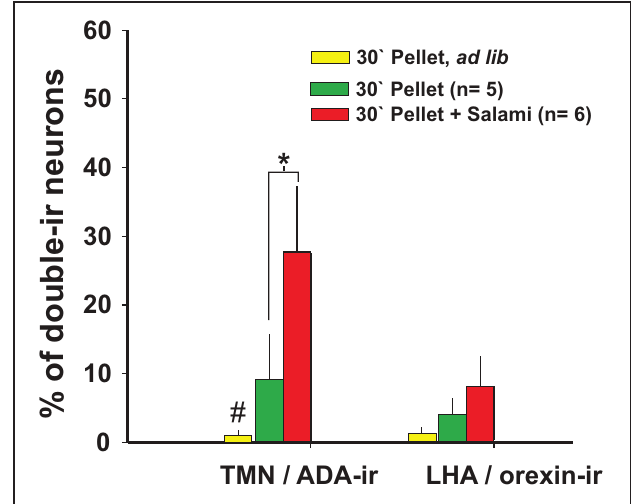
FIGURE 4 | The number of TMN active neurons that responded to enticing was dependent on the homeostatic state and palatability of the stimulus: Orexin neurons from the LHA did not respond to enticing. # Different from the other conditions; ∗ different from the pellet plus salami. Modified from Valdes et al.